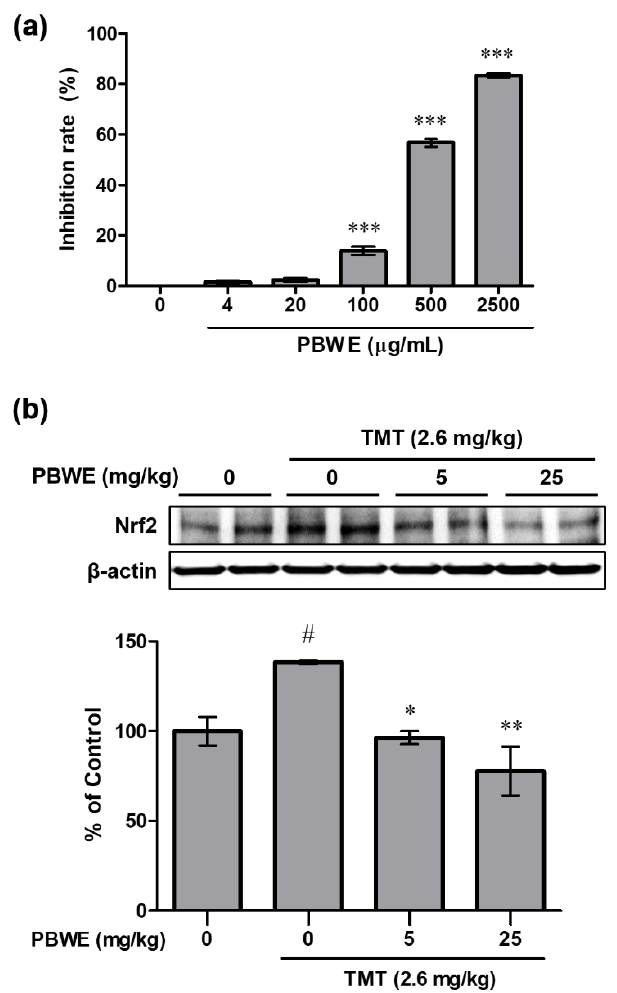
Figure 5. Antioxidative potential of the Protaetia brevitarsis seulensis’ water extract (PBWE) and protein expression of nuclear factor erythroid 2-related factor 2 (Nrf2) in the PBWE and trimethyltin (TMT)-treated mouse hippocampus. ( a ) In the 2,2-diphenyl-1-picryl-hydrazyl-hydrate assay, the PBWE markedly scavenged the free radicals in a dose-dependent manner. *** p < 0.001 vs. 0 µ g/mL of PBWE-treated group. ( b ) PBWE pretreatment abrogated the increased protein expression of Nrf2 on day 4 post-TMT treatment. Values are reported as mean ± SE. # p < 0.05 vs. saline-treated group, * p < 0.05 and ** p < 0.01 vs. TMT-alone treated group.